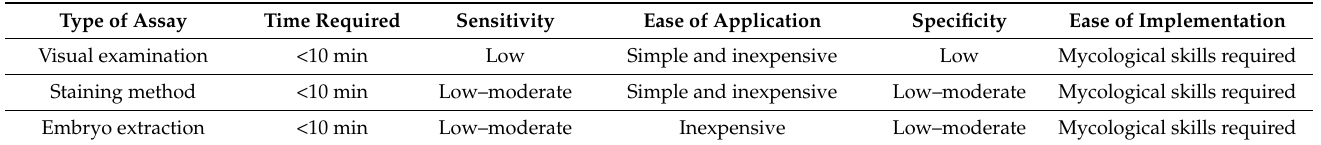
Table 2. Mean features of seed health methods including time required form completion, sensitivity, ease of application, specificity, and ease of implementation. Modified from Kumar et al.